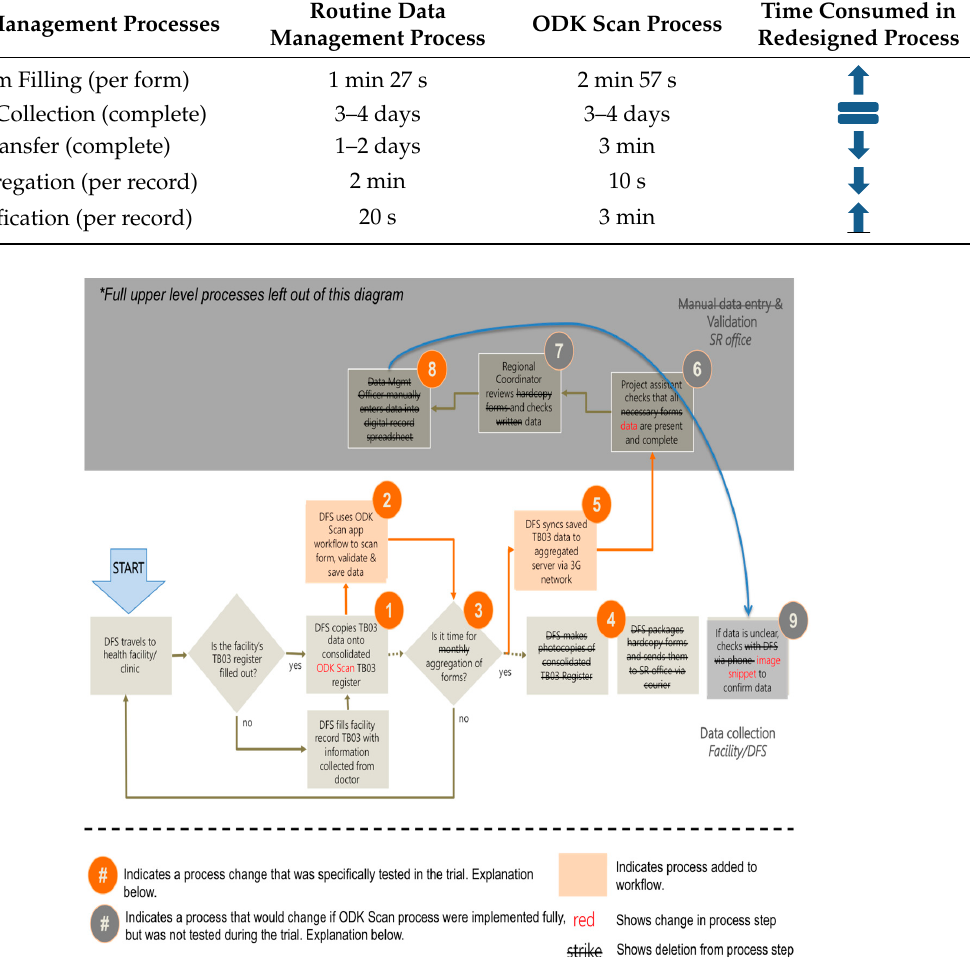
Figure 6. Redesigned data management process in ODK Scan paper ‐ to ‐ digital system.